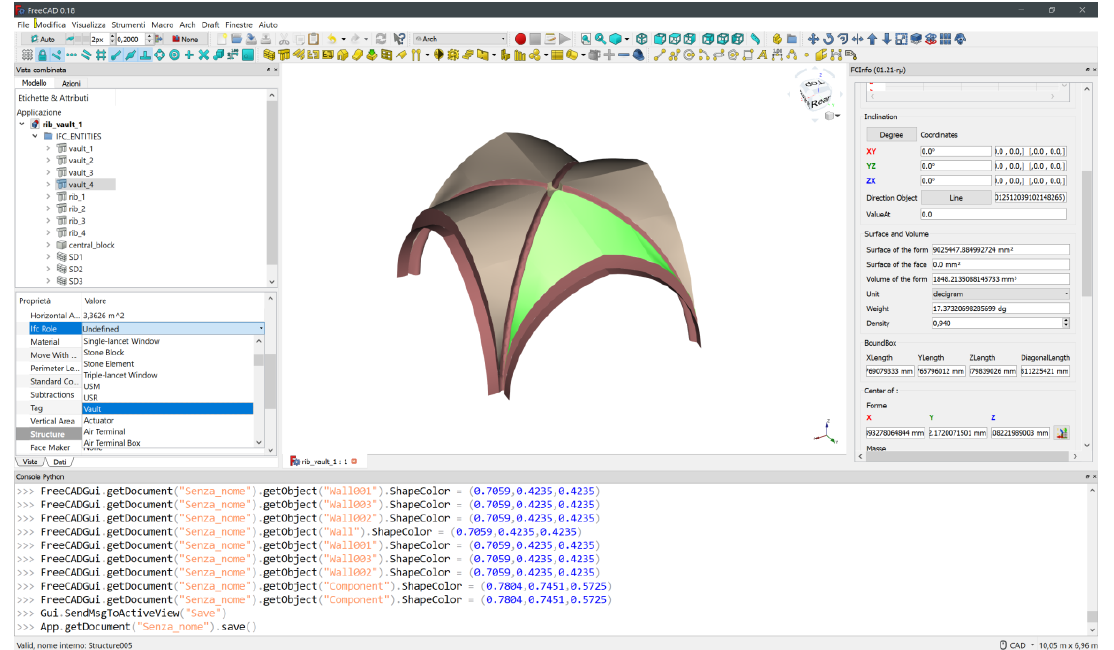
Figure 6. IFC classification of vaults by implementing ifcRoof entity by using vault as custom roles inside the default schema.